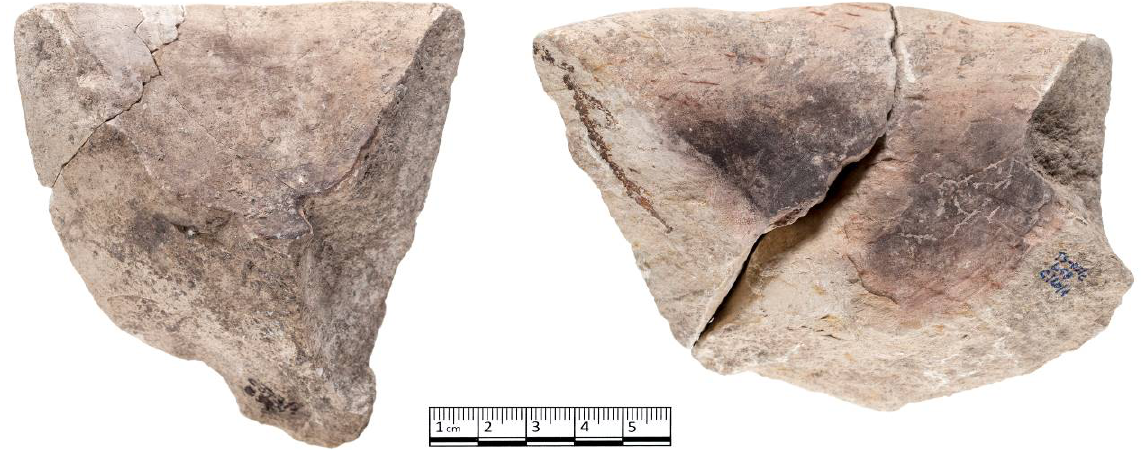
Figure 7: Burn marks on limestone-pedestalled